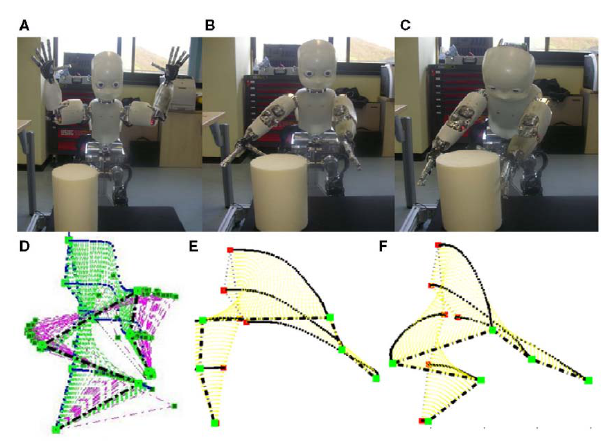
FIGURE 4 | Effects of modulating the admittance in the intrinsic space on the final posture achieved through PMP relaxation. (A) Shows the initial condition with the goal being issued to reach the large cylinder (placed far away and asymmetrically with respect to the robot’s body) using both arms. (B) Shows the final solution when the admittance of the three DoF of the waist is reduced 10 times as compared to the two arms. Without the contributions of the additional DoF of the torso, it is not possible to bimanually reach the target. An alternative way to interpret this behavior is that the force field induced by the goal did not propagate through the waist network because of its lower admittance (in comparison with the arm networks). In other words, the propagation of goal induced force field across different intrinsic elements of the body can be modified by altering their “local” admittance. (C) Shows the solution when the waist admittance is made equal to the arms. In this case, note the contributions from all three degrees of freedom of the torso (B) , hence enabling iCub to bimanually reach the cylinder successfully in this case. (D–F) Show a simple scenario where the goal is to reach a target using the whole body but also attain a specific posture as demonstrated by the teacher [ (D)